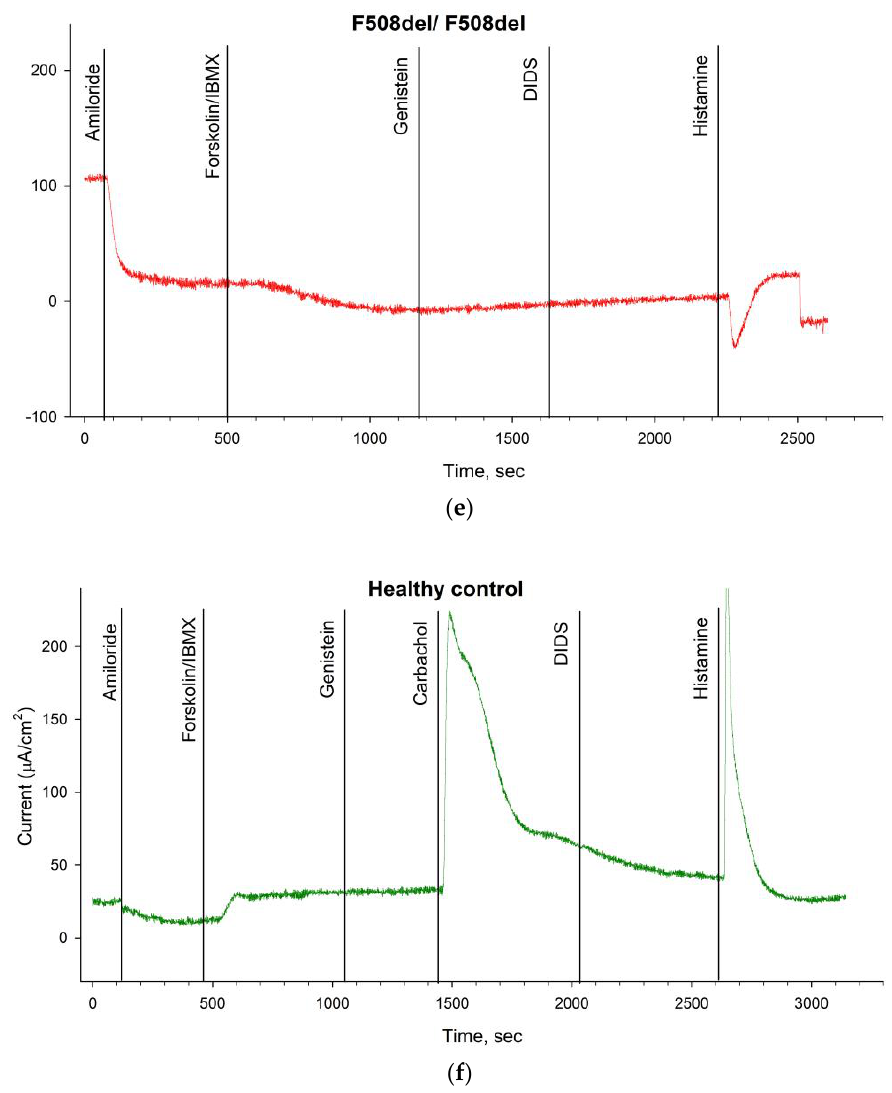
Figure 2. Intestinal current measurements (ICM) for patients carrying the genetic variant E92K; ( a ) E92K/E92K genotype (Group 1). With the introduction of amiloride, there was a decrease in the short−circuit current (ΔISC), in response to forskolin/IBMX, there is an increase in ΔISC, and a change in the short−circuit current in the negative direction was noted for the addition of histamine; ( b ) E92K/I class genotype (Group 2). With the introduction of amiloride, there was a decrease in the short−circuit current (ΔISC), in response to forskolin/IBMX, there is an increase in ΔISC, and a change in the short−circuit current in the negative direction was noted for the addition of histamine; ( c ) E92K/F508del genotype (Group 3). With the introduction of amiloride, there was a decrease in the short−circuit current (ΔISC), in response to forskolin/IBMX, there is an increase in ΔISC, and a change in the short−circuit current in the negative direction was noted for the addition of histamine; ( d ) E92K/IV−V classes genotype (Group 4). When amiloride is administered, the response is not fixed, in response to forskolin/IBMX, there is an increase in a decrease in the short−circuit current (ΔISC), and a change in the short−circuit current in the negative direction is noted for the addition of histamine; ( e ) F508del/F508del genotype (Group 5). When amiloride was administered, there was a decrease in the short−circuit current (ΔISC), but no changes were observed in response to the introduction of forskolin/IBMX, and a negative change in the short−circuit current was observed in response to the addition of histamine; ( f ) healthy individual (control). The addition of amiloride caused a decrease in ΔISC, there was a significant increase of ΔISC in response to forskolin/IBMX, while the addition of histamine led to a change of short−circuit current in the positive direction.